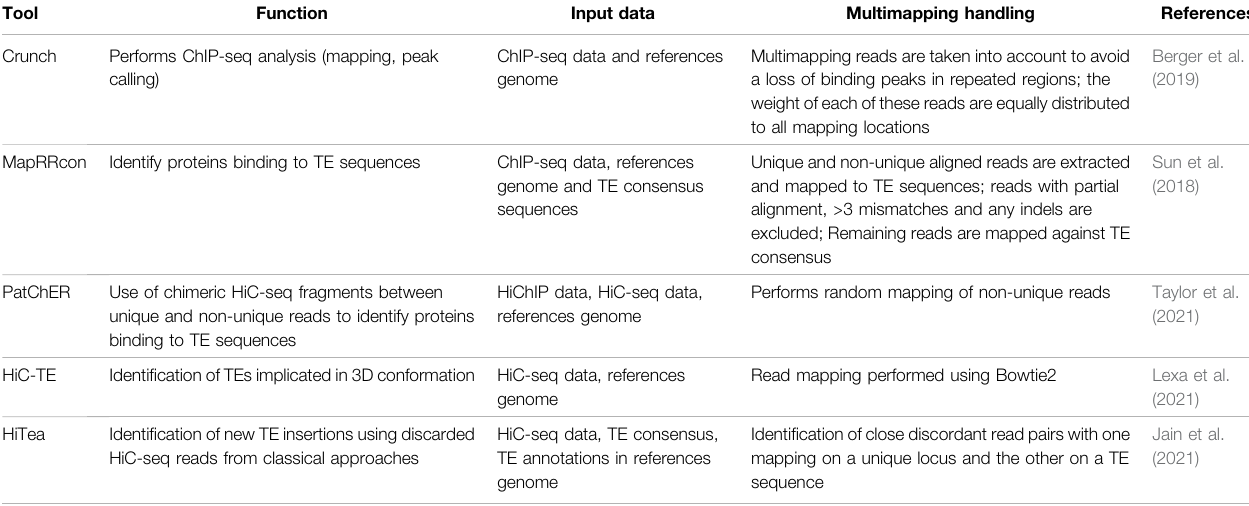
TABLE 2 | Recent tools for the identi fi cation of TEs in chromatin structure and chromosome-chromosome interactions.